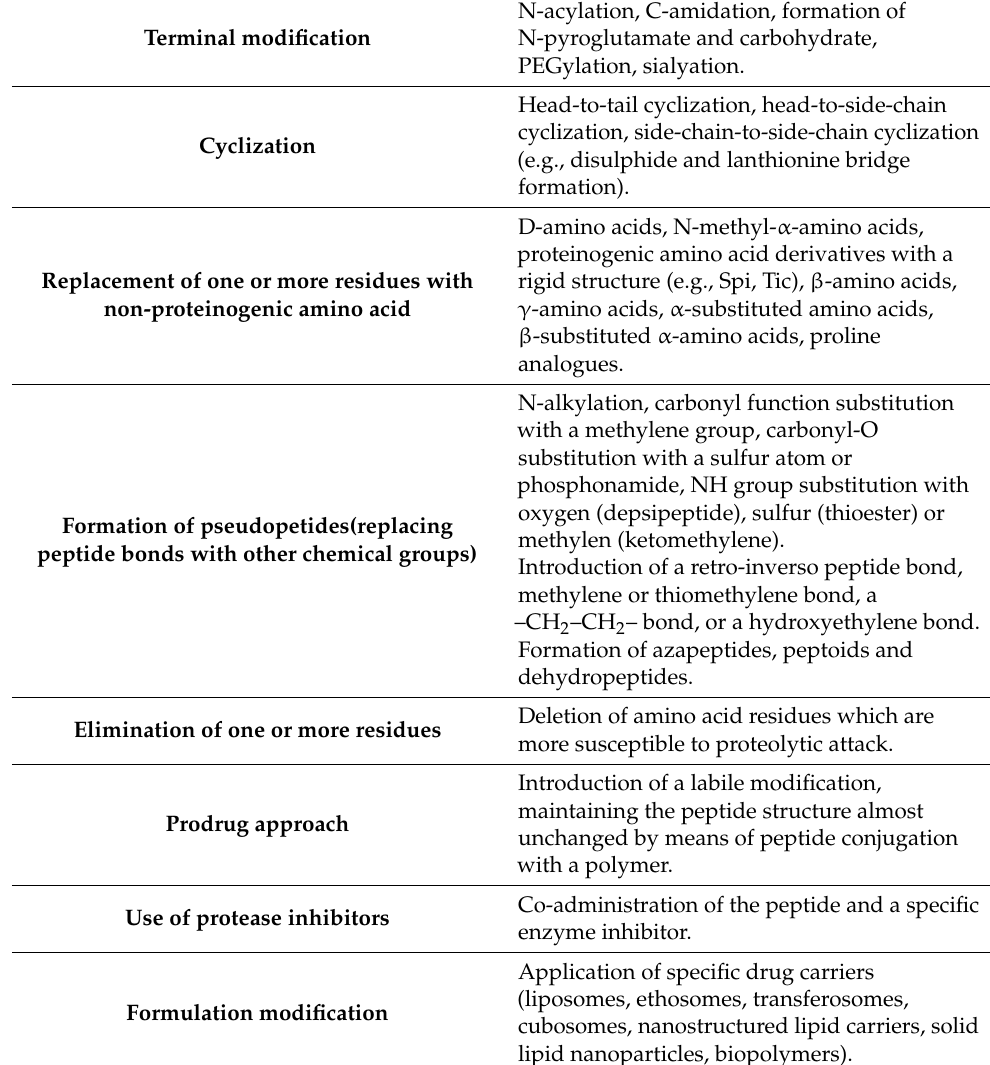
Table 2. Principal strategies to enhance the proteolytic stability of